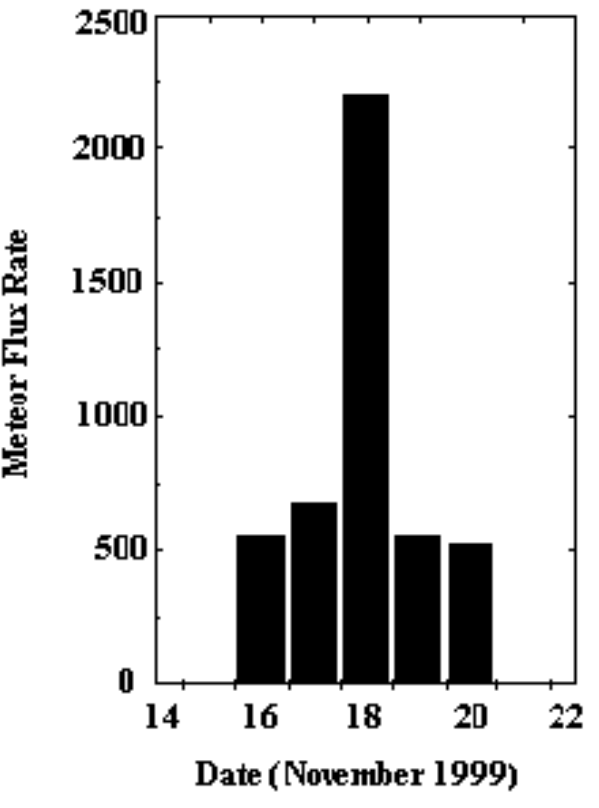
Fig. 2. Day-to-day variation of the rate of formation of meteor trails during LMS period.